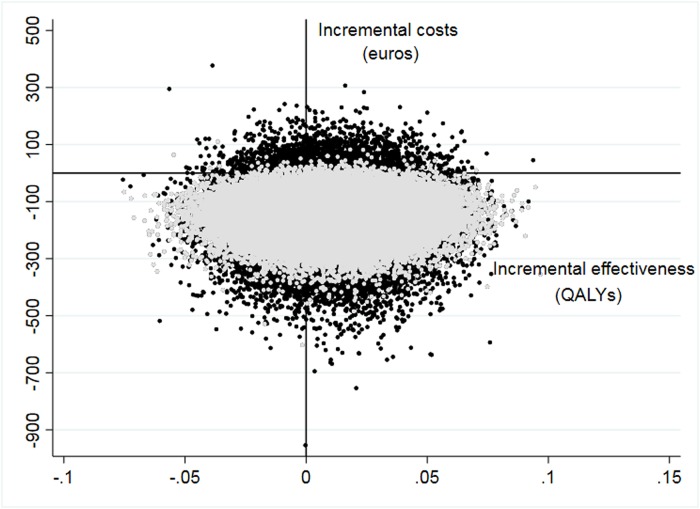
Cost-effectiveness plane.Scatterplot showing the posterior incremental cost and effectiveness measured by QALYs. Grey dots represent OSA-related costs and black dots represent total costs.